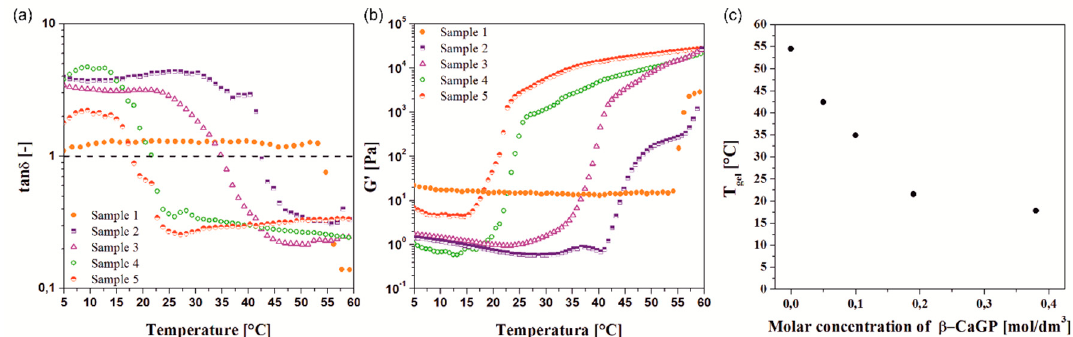
Figure 3. The effect of calcium β -glycerophosphate on ( a ) the curve of damping factor tan δ in non-isothermal conditions, ( b ) the change of storage modulus G’ under non-isothermal conditions, and ( c ) the dependence of sol-gel phase transition temperature.